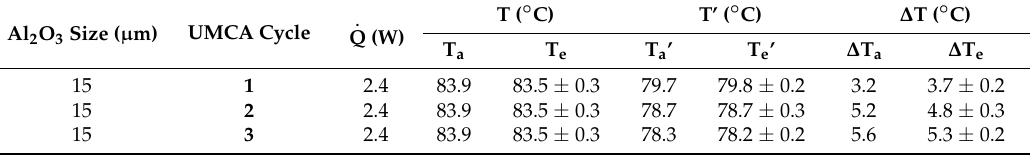
Table 4. Effects of UMCA cycles when comparing the temperatures obtained from the analytical model (all with subscript a) and the experiment (all with subscript e), using the 15 µ m Al 2 O 3 powders for one to three UMCA cycles and all under a total heat input power surface is 41%, 51%, and 55% for cycles 1–3, respectively.